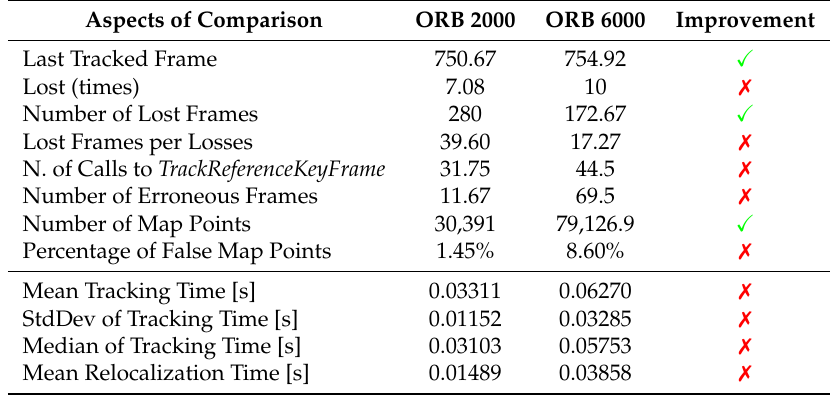
Table 3. Comparison table for the ORB-SLAM executions for 2000 and 6000. Average values for 10 executions. Aspects of